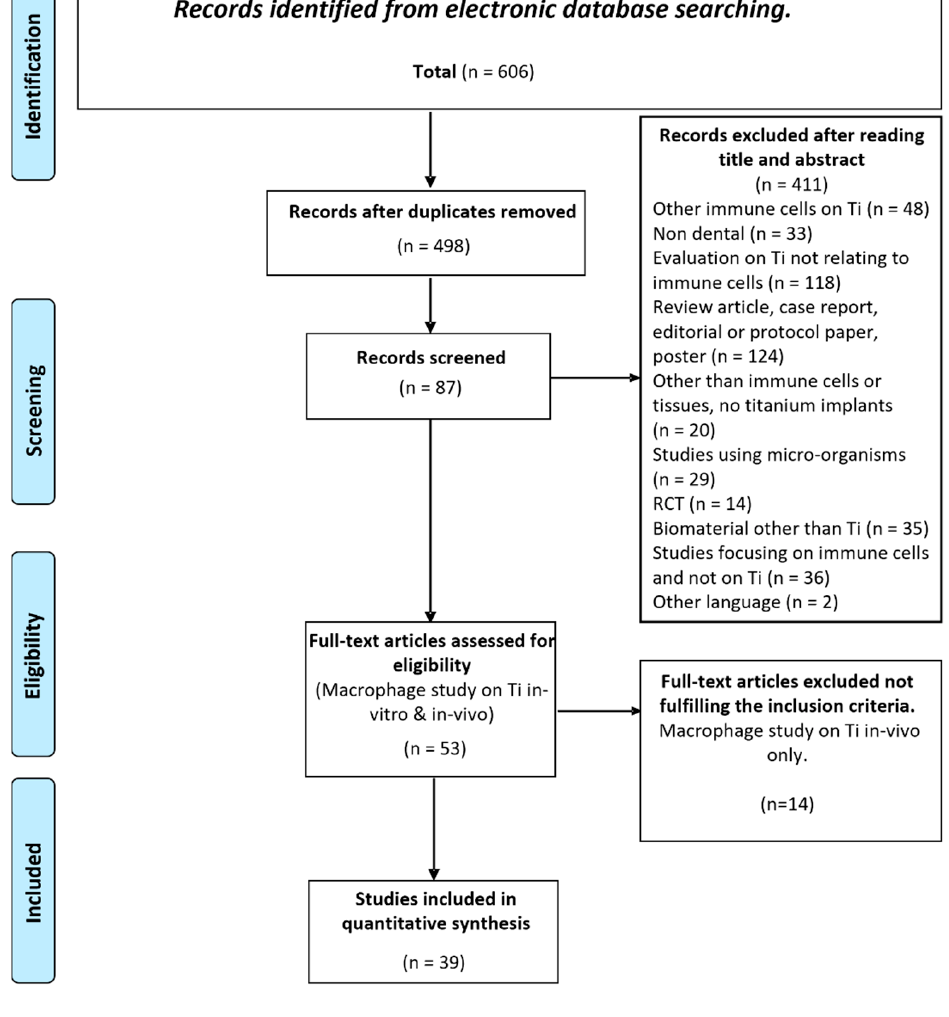
Figure 1. PRISMA flowchart of the screening process for the selected databases.